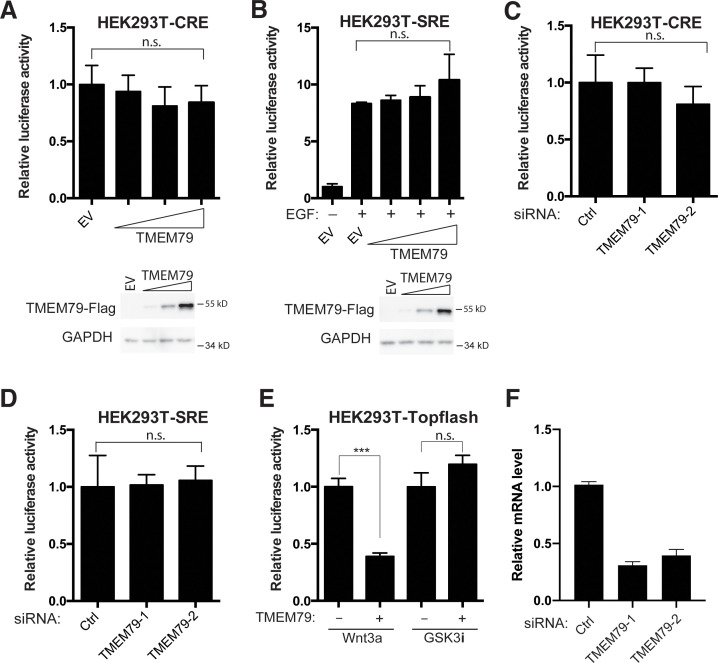
TMEM79 is a specific inhibitor for Wnt/β-catenin signaling.(A and B) TMEM79 affects neither the cAMP/PKA pathway, assayed by a CRE (cAMP responsive element)-driven reporter, or the EGF/EGFR pathway, assayed by an SRE (serum response element)-(driven reporter). (C and D) Depletion of TMEM79 by siRNAs affects neither the CRE- or SRE-driven reporter. (E) TMEM79 inhibits the TOP-Flash reporter induced by Wnt3a but not that induced by a GSK3 inhibitor (GSK3i). (F) Relative mRNA levels of TMEM79 in HEK293 cells transfected with indicated siRNA.Figure 2—figure supplement 1—source data 1.Raw data for Figure 2—figure supplement 1.